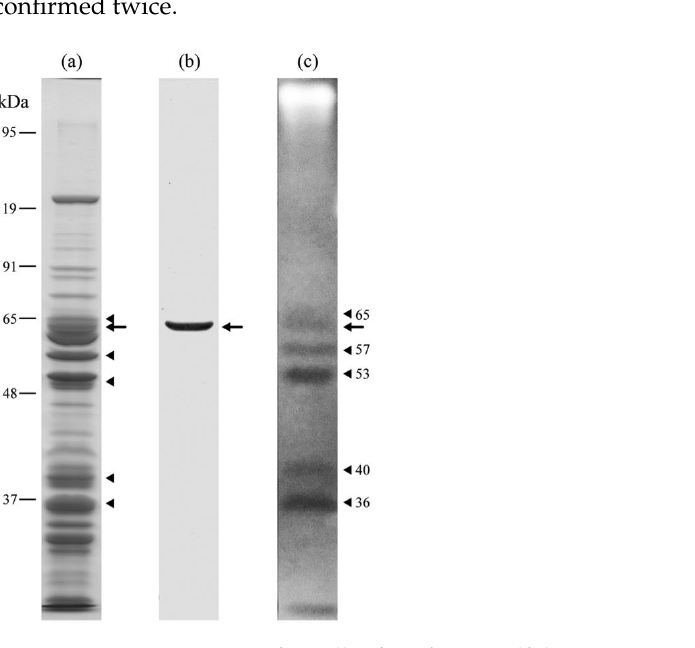
Figure 3. SDS-DNA PAGE of IF cells of H. obtusa. Calf thymus DNA was used. ( a ) CBB stained gel; ( b ) immunoblot with mAb3D1B9C4 specific for PRP1; ( c ) EB stained gel. Arrows, PRP1. Arrowheads, other EB-staining negative bands showing positions of DNA-protein complexes (see Materi- als and Methods section).